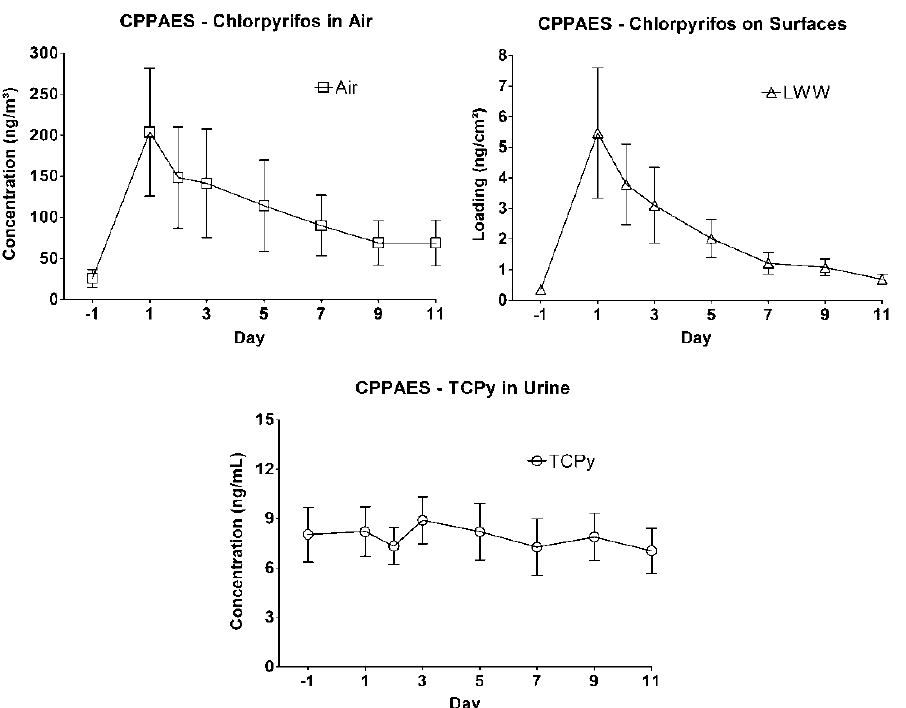
Figure 2. Time profiles for chlorpyrifos in environmental media and TCPy concentrations in urine for all children in the CPPAES following crack and crevice treatment.